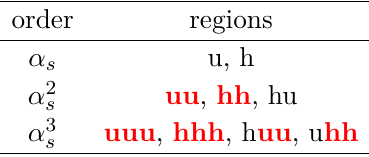
Table 1 . Relevant regions for the loop momenta k 1 , k 2 , k 3 up to O ( α 3 (u). Regions written in black factorize, leaving at most two- or three-loop integrals (in red) to be reduce by means of IBP